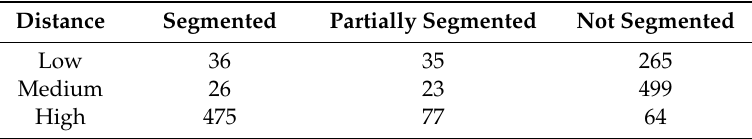
Table 4. Results of land segmentation using the Flood Fill method.